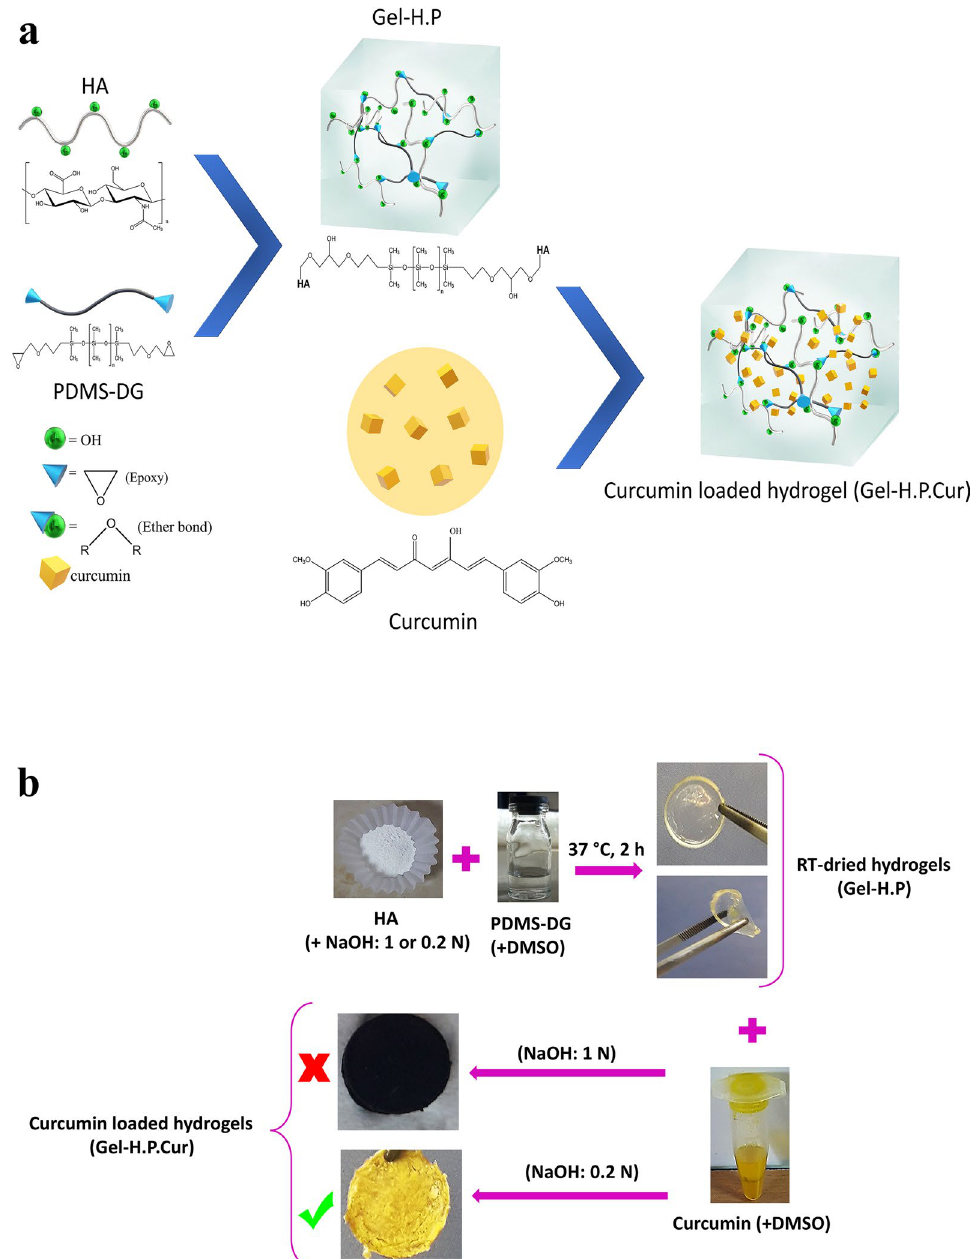
Fig. 1 Synthesis of Gel-H.P and Gel-H.P.Cur. a Schematic and b Original materials representation. HA was incubated at basic pH, and the interaction of epoxide groups with the HA hydroxyl groups leads to ether bond formation. This cross-linking reaction created the HA-PDMS 3D hydrogel network. By adsorbing and penetrating curcumin in the Gel-H.P (at appropriate pH condition) the color completely converted to yellow even in the inner parts of